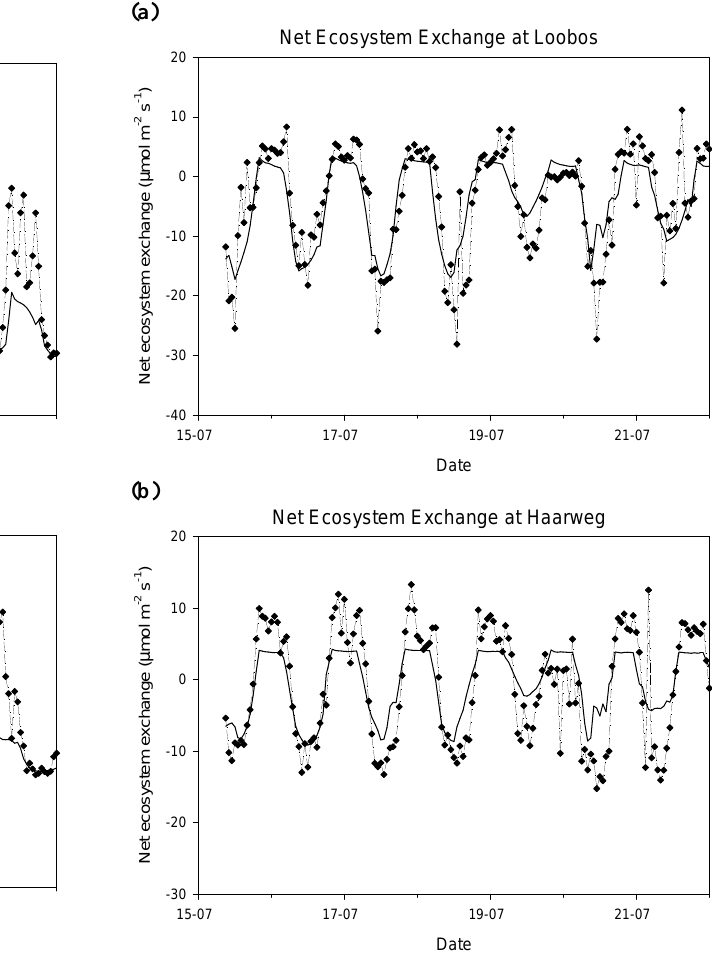
Fig. 9. Comparison of observed and simulated CO 2 fluxes (µmolm − 2 s − 1 ) for Loobos (a) and Wageningen (b) . Diamonds and dotted lines: observed values; black lines simulated at a grid- point nearest to the observational site and representing the appro- priate